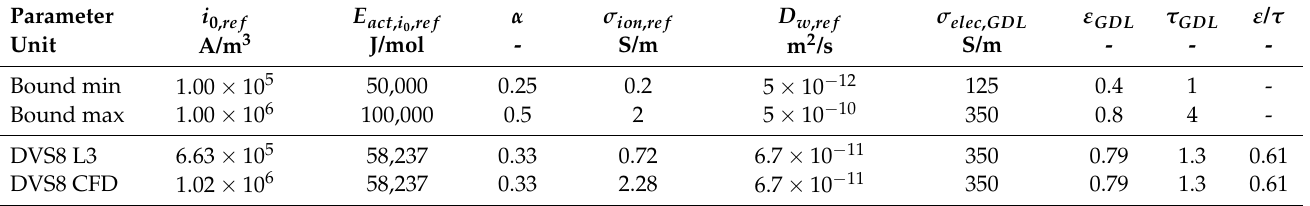
Table 6. Numerical optimization results with quasi-3D model (DVS8 L3) and final parameter set of SCM and HCM (DVS8 CFD) are shown. The differences between the two sets are in i 0, ref and σ ion , ref